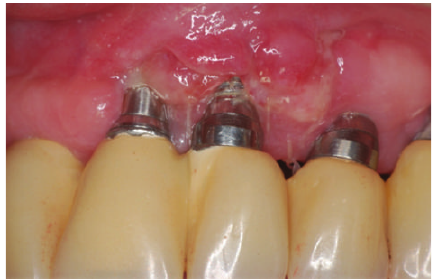
Figure 14: One year after the surgery. Note the almost total coverage of the implant platform.